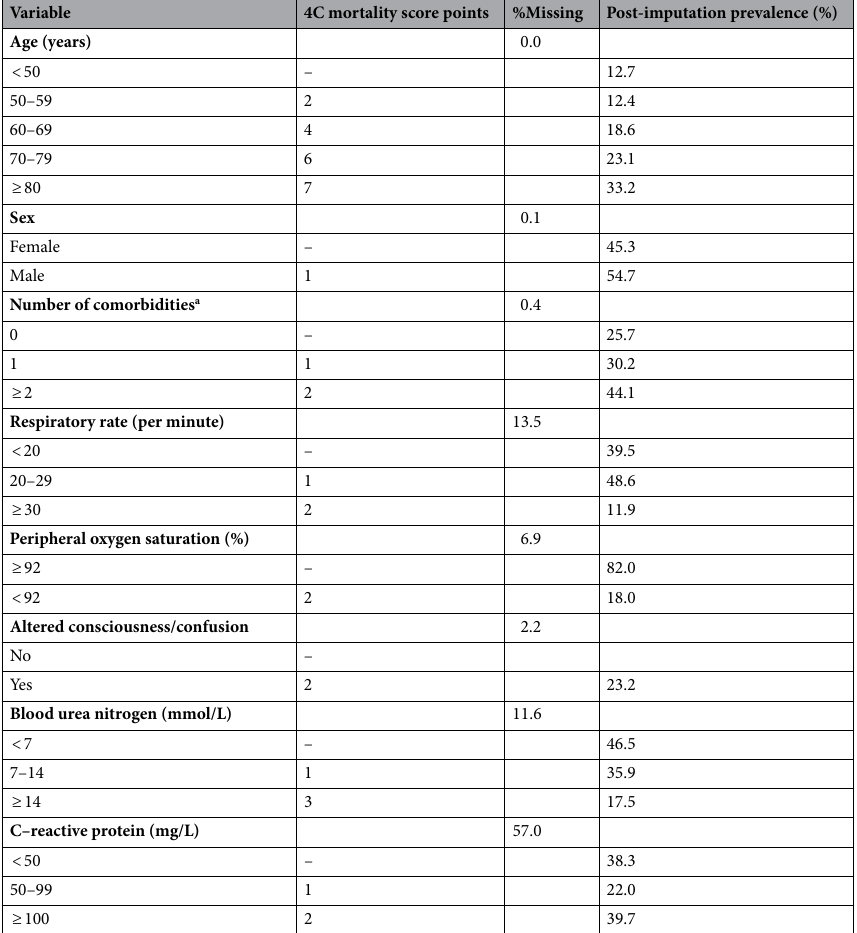
Table 2. Components of the 4C mortality score, missingness, and post-imputation prevalence. Adapted from https:// www. bmj. com/ conte nt/ 370/ bmj. m3339. a Includes chronic lung disease (excluding asthma),